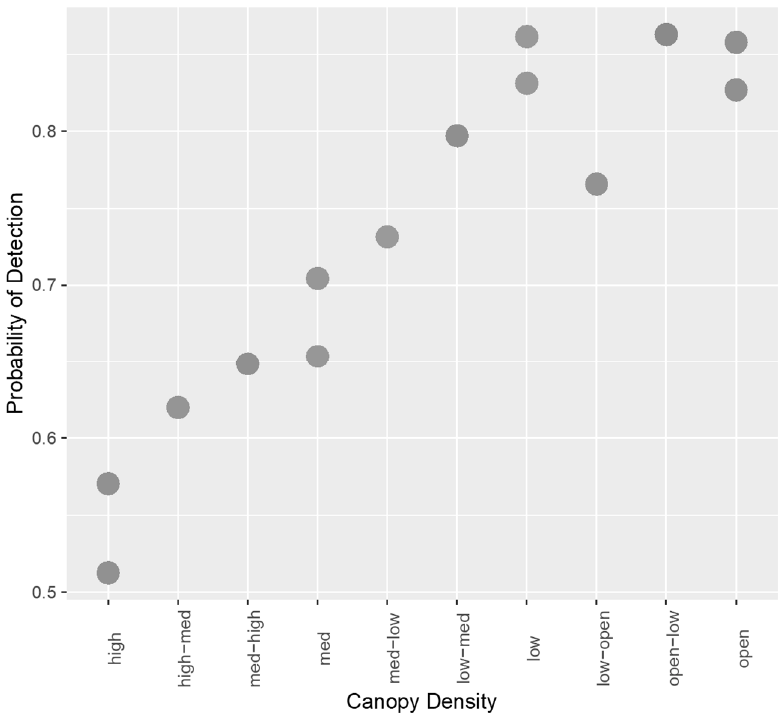
Figure 4. Scatterplot showing the relationship between increasing canopy density and probability of detection for TIR images with automated detection. Table 5. The model with the best fit to the data for TIR images with automated detection includes the variables camera angle and canopy